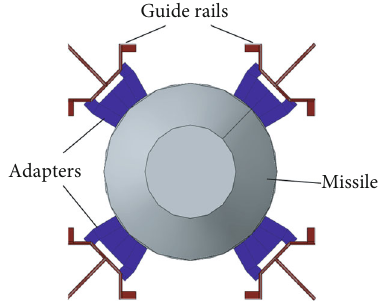
Figure 4: Missile, adapters, and guide rails.